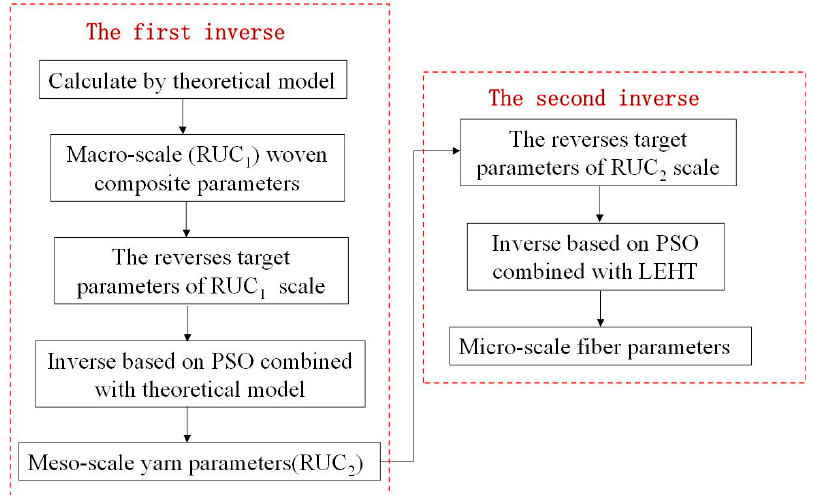
Figure 2. Two-step inverse flowchart for woven composite optimization.